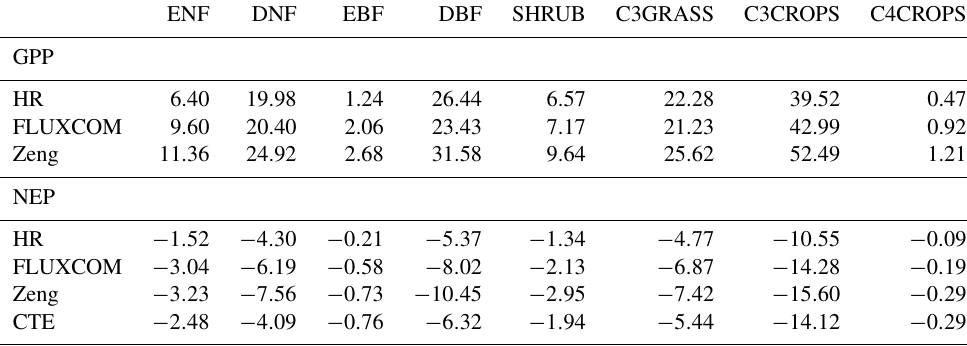
Table 7. Gross primary production (GPP) and net ecosystem productivity (NEP), integrated over the growing season (MJJA) of 2017 (TgC/month) for different land-use types (ENF: evergreen needleleaf forests; DNF: deciduous needleleaf forests; EBF: evergreen broadleaf forests; DBF: deciduous broadleaf forests; SHRUB: shrublands; C3GRASS: C 3 grasslands; C3ROPS: C 3 croplands; C4CROPS: C 4 crop- lands). The land-use types are taken from the CORINE dataset (Bossard et al., 2000). HR refers to the product described here, Zeng refers to the product as described by Zeng et al. (2020), FLUXCOM refers to the product by Jung et al. (2020), and CTE refers to NEP optimized using data assimilation of atmospheric CO 2 mole fraction observations (Friedlingstein et al., 2022b). ENF DNF EBF DBF SHRUB